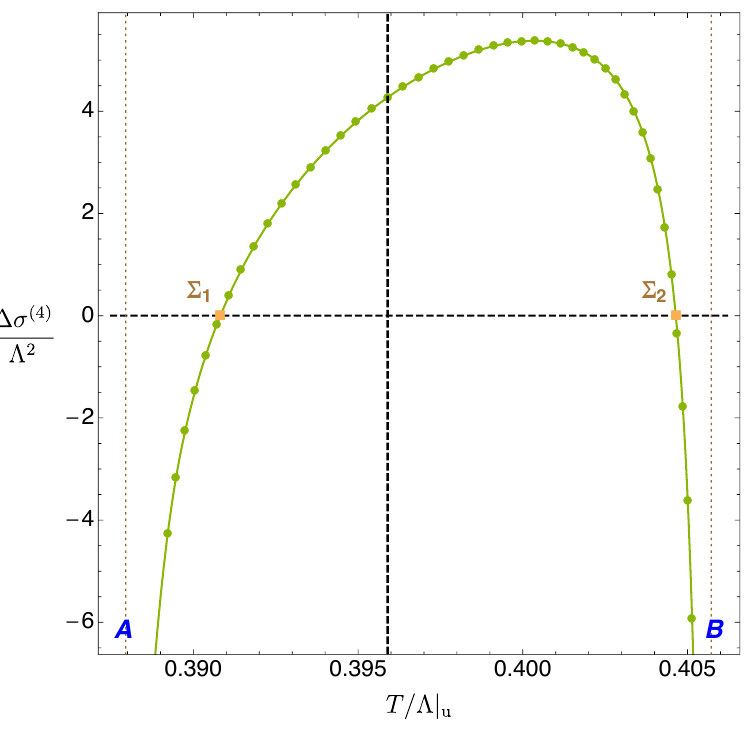
Figure 10 . Perturbative identification of the dominant microcanonical phase. The horizon- tal axis shows the temperature ˆ T u of the uniform brane that has the same (ˆ L, ˆ ρ ) as the lumpy brane we compare it with. The vertical axis shows the difference between the Killing entropy densities of the lumpy and the uniform branes. Thus lumpy branes (uniform branes)